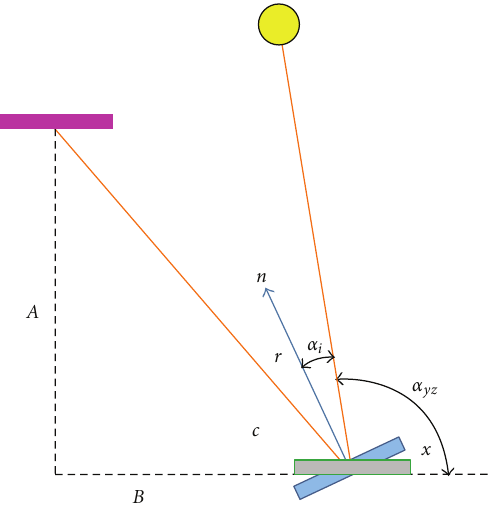
Figure 3: Rotation of a mirror and its configuration